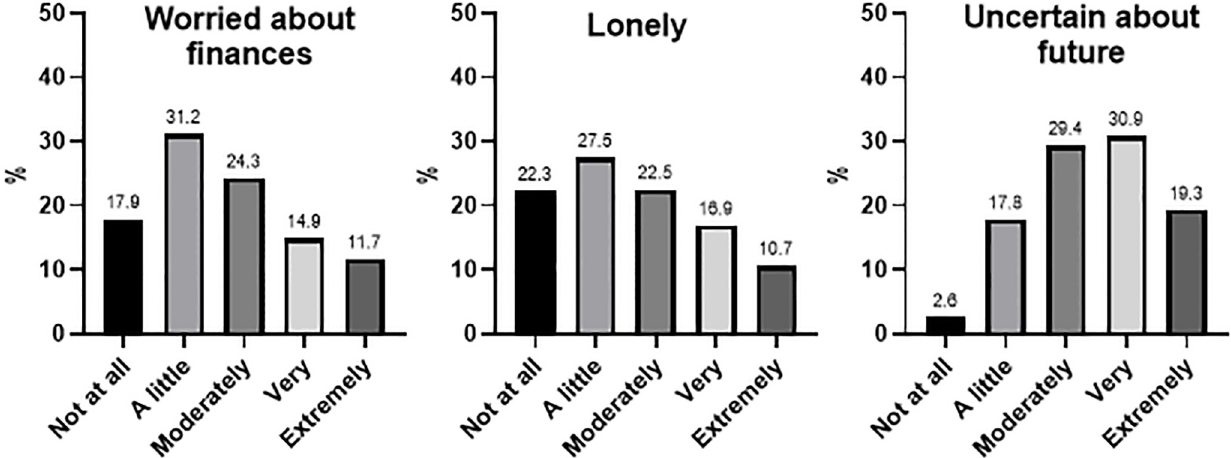
Fig 2. Proportion (% of total sample) of participants reporting worry about finances, uncertainty about the future and feelings of loneliness.